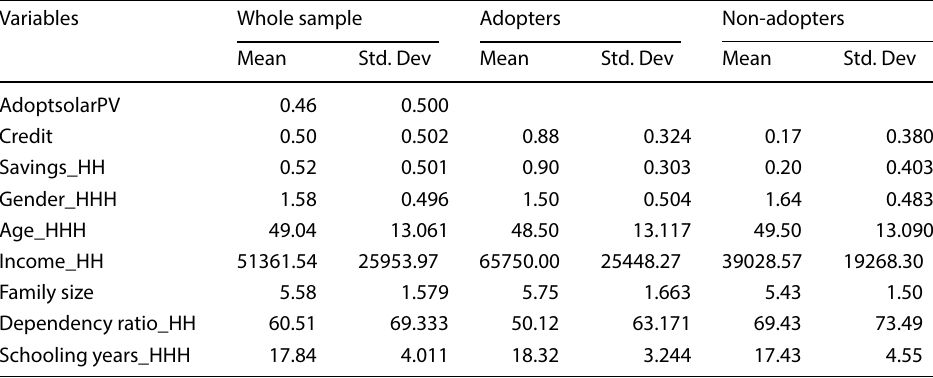
Table 2 Descriptive statistics of variables and mean differences for adopters and non-adopters. Source: